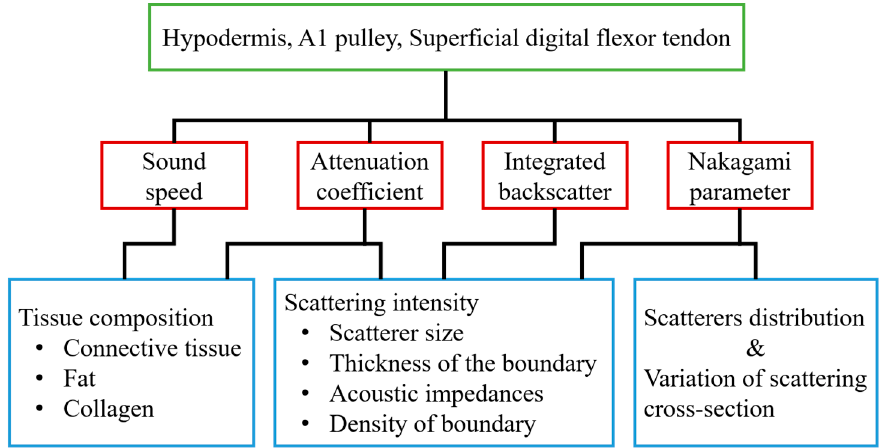
Figure 8. The major factors associated with the quantitative parameters used in this